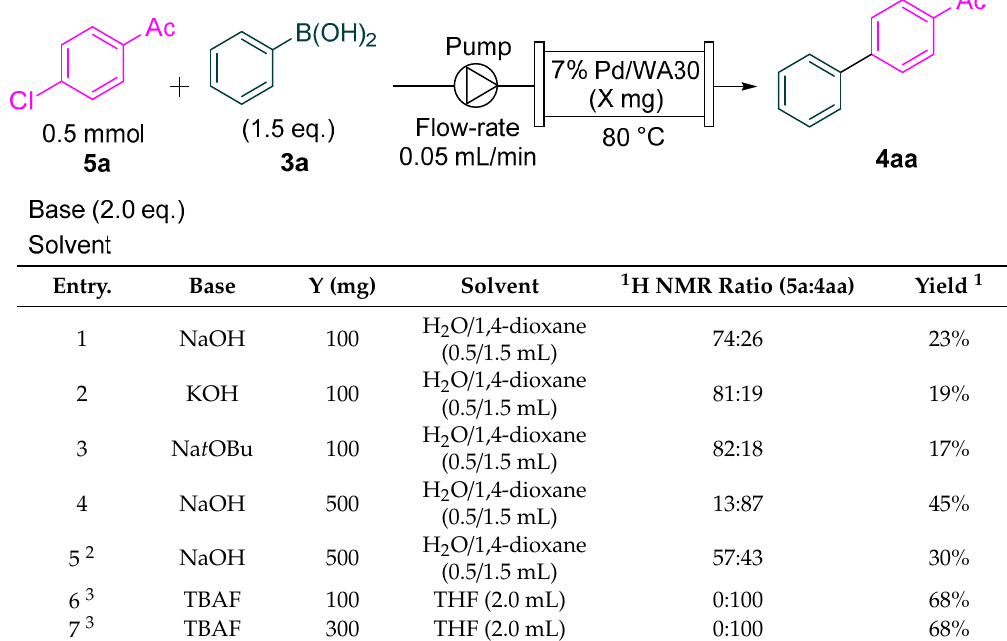
Table 3. Optimization of 7% Pd/WA30-catalyzed continuous-flow Suzuki–Miyaura coupling reaction of 4’-chloroacetophenone ( 5a ) with phenylboronic acid ( 2a ).